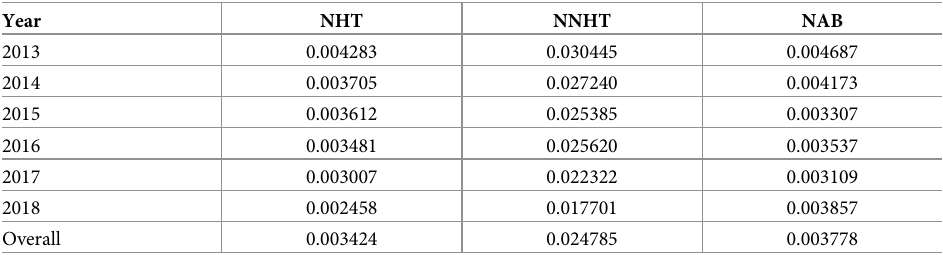
Table 6. The shadow price of inputs from 2013 to